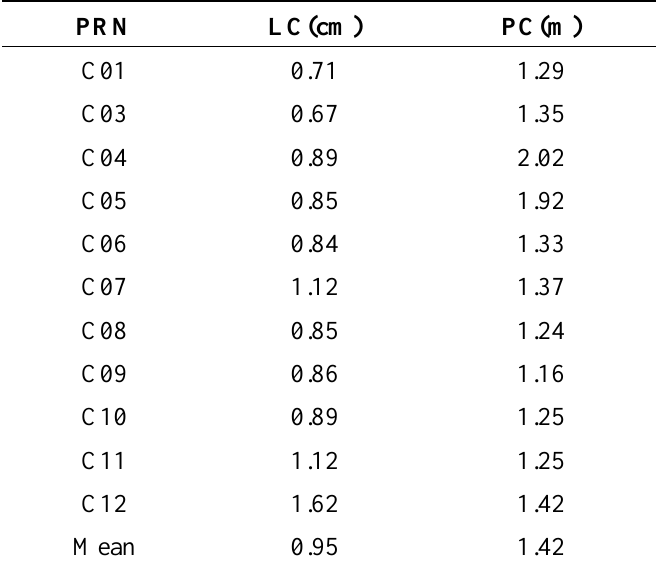
Table 3. Average values of the RMS of undifferenced LC and PC residuals for all BeiDou